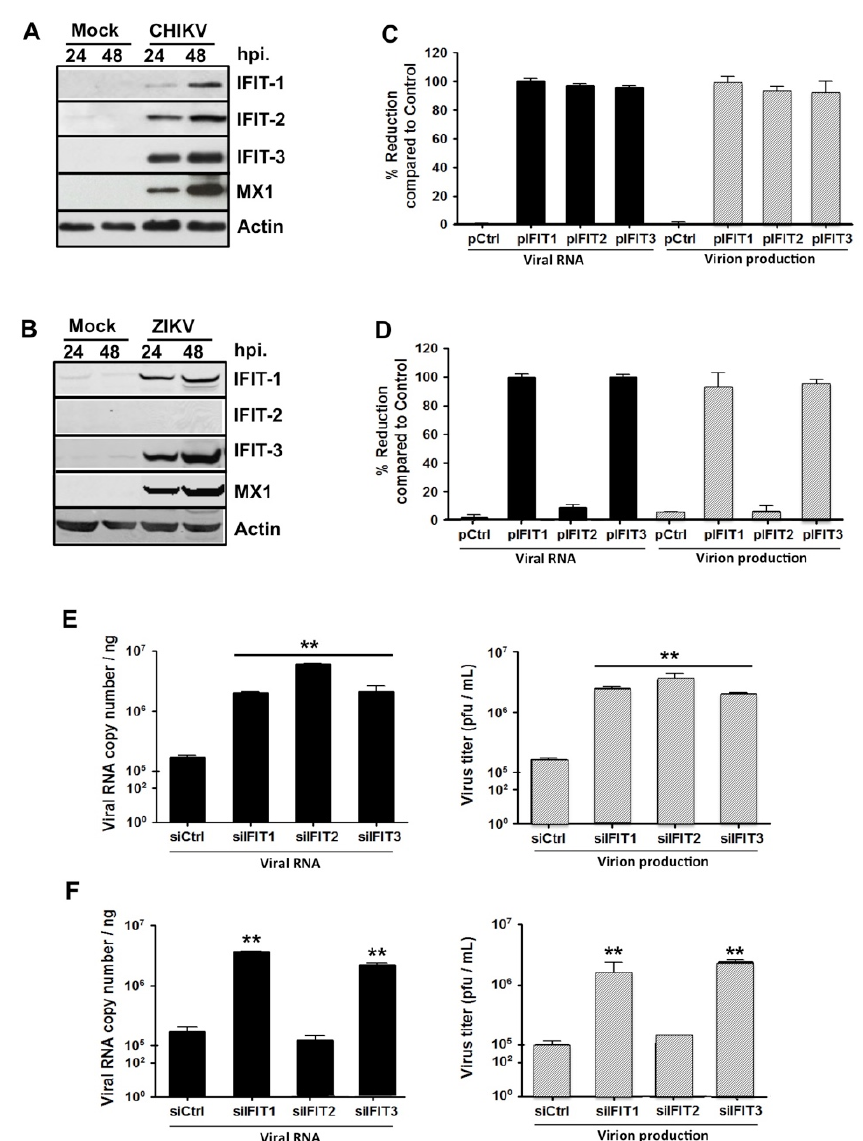
Figure 2. IFITs modulate CHIKV and ZIKV replication in HFF1 cells. ( A ) HFF1 cells were infected with CHIKV at a multiplicity of infection (MOI) of 1.0. At 24 and 48 hpi, infected cells were lysed with TETN-150 and analyzed by immunoblotting for the expression of IFIT1, IFIT2, IFIT3, MX1 and β-actin. ( B ) Similar to ( A ) but using ZIKV at a MOI of 1.0. For both ( A , B ), mock-infected cells were used as control. ( C ) CHIKV and ( D ) ZIKV RNA and infectious virus production were determined at 48 hpi in HFF1 cells transfected with an empty plasmid (pCtrl) or the same plasmid encoding IFIT proteins (pIFIT1, pIFIT2 and pIFIT3) by quantitative RT-PCR (black bars) and plaque assay (gray bars), respectively. The percentage of reduction as a function of the presence of each plasmid was calculated using the formula [1 − (R/C)] × 100, where C and R designate experimental values (RNA copy numbers or plaque numbers) in the presence of pCtrl and pIFIT, respectively. ( E ) CHIKV and ( F ) ZIKV RNA and infectious virus production were determined at 48 hpi in cells transfected with control siRNA (siCtrl) or siRNA, specific for IFIT (pIFIT1, pIFIT2 and pIFIT3) by real time RT-PCR (black bars) and plaque assay (gray bars), respectively. The data represent the mean values ± SD from three independent experiments. ** p < 0.01, as compared to siCtrl transfected cells. To study the functional role of IFITs proteins in the viral infection process, their genes were either overexpressed or their expression was suppressed in HFF1 cells using specific RNA